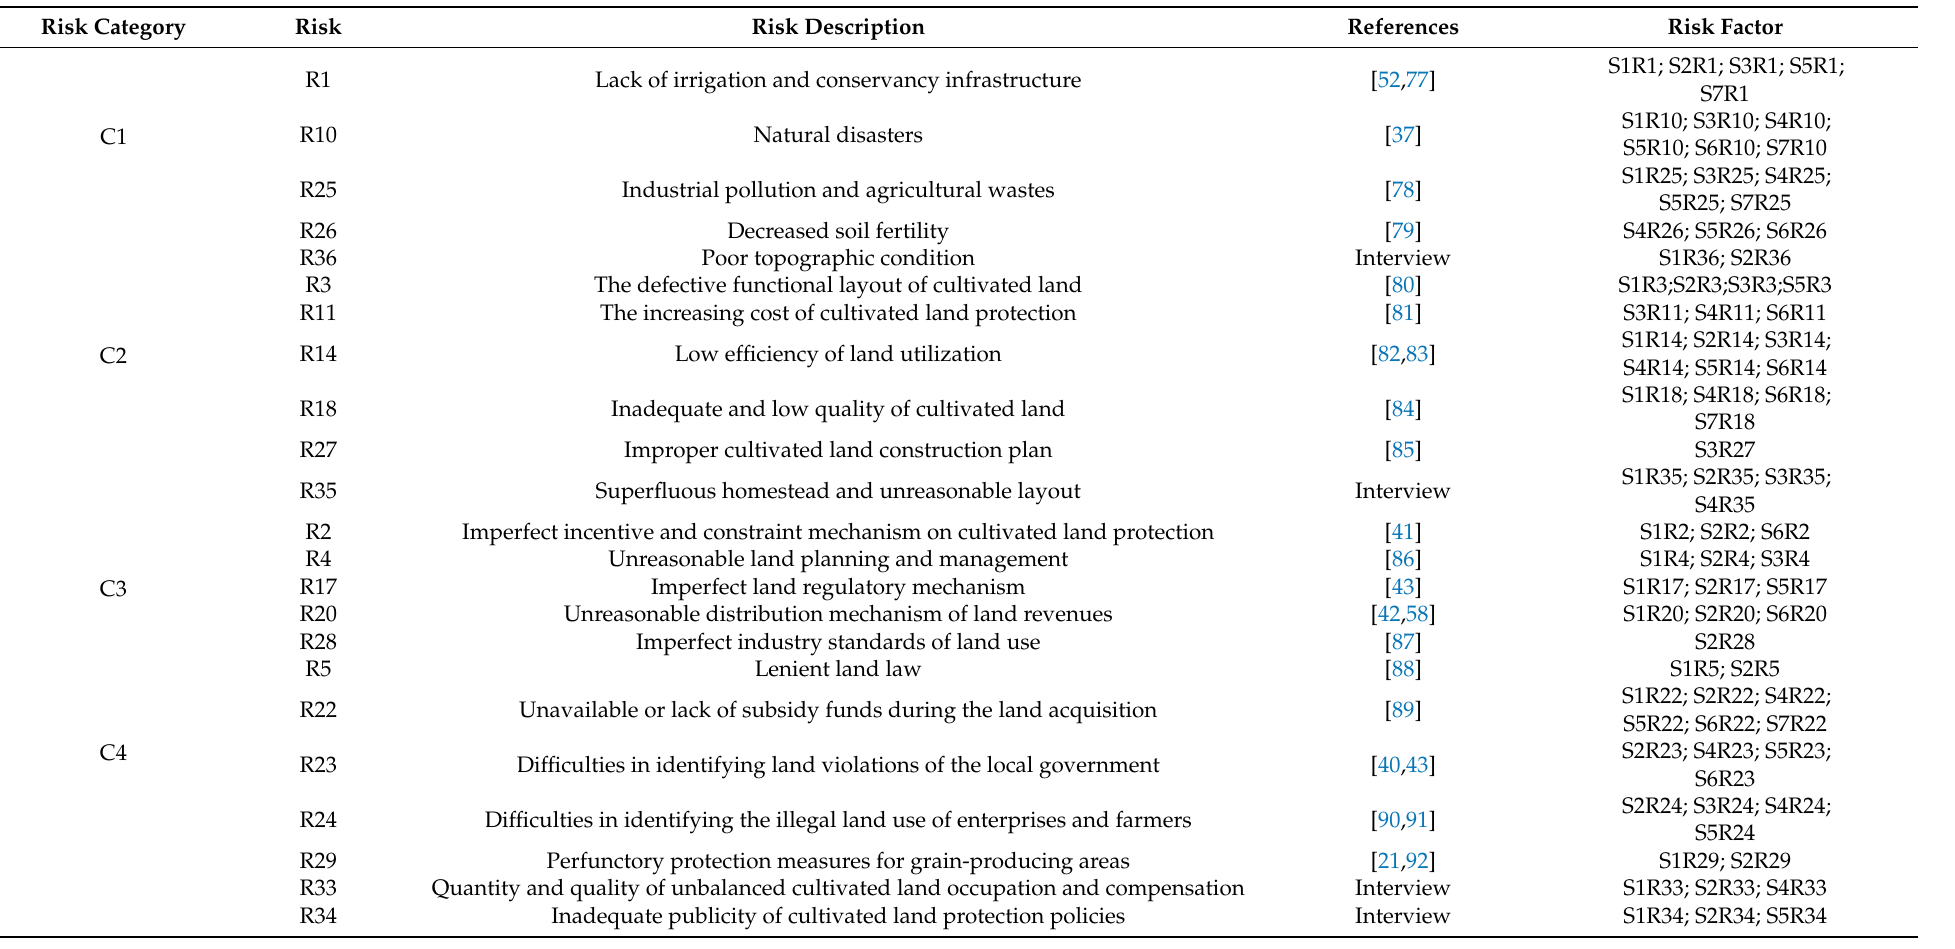
Table 1. Risk factors and corresponding stakeholders in cultivated land